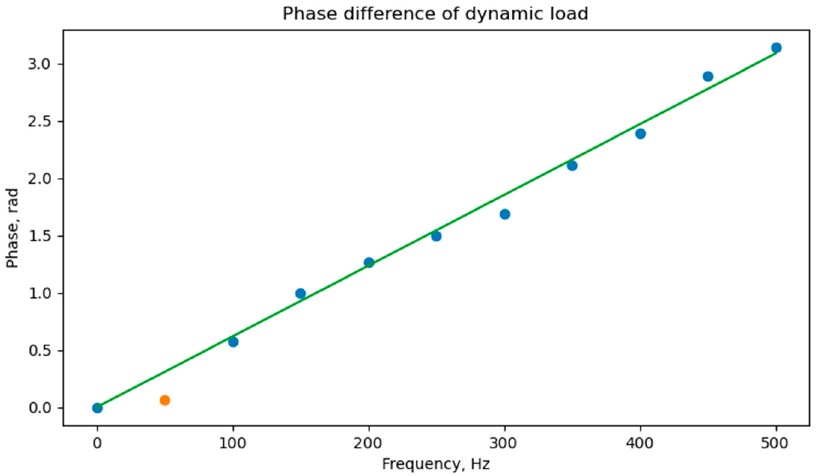
Figure 9. Phase spectrum of the simulated signal arriving at two sensors.